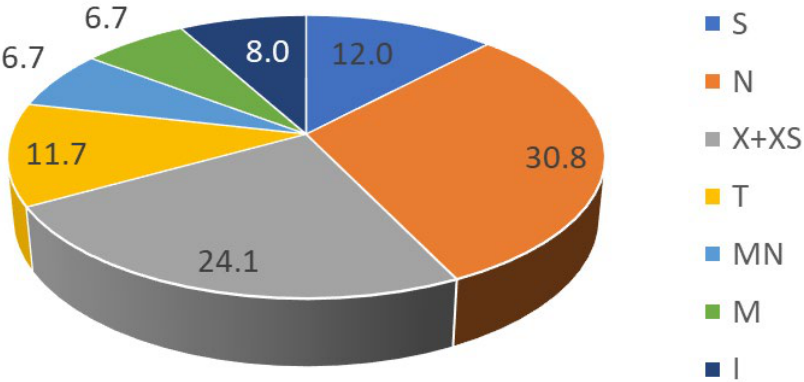
Figure 5. Percentage of species pertaining to the different chorological categories (S: Southern; N: Northern; X + XS: Endemic; T: Trans-Iberian; MN: Northern Mediterranean; M: Mediterranean; I: Introduced.